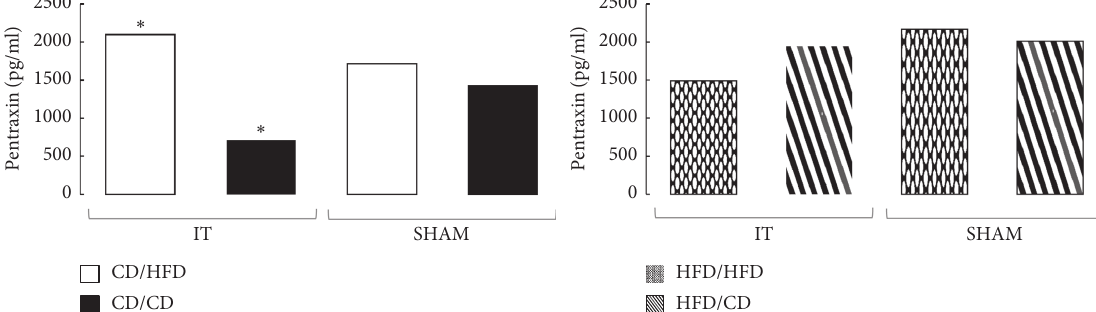
Figure 4: Median of PTX3 plasma concentration in four diet groups according to operation type. Abbreviations: IT—ileal transposition, SHAM—sham operated animals, CD—control diet, and HFD—high-fat diet. Preoperative diet/postoperative diet: CD/HFD, CD/CD, HFD/ HFD, HFD/CD (group size: n � 6, except IT HFD/HFD: n � 5). Sign ∗ denotes significant difference between median values; Kruskal–Wallis test, p < 0 . 05. Quartile deviation (Q25 and Q75) available in Supplementary Materials.